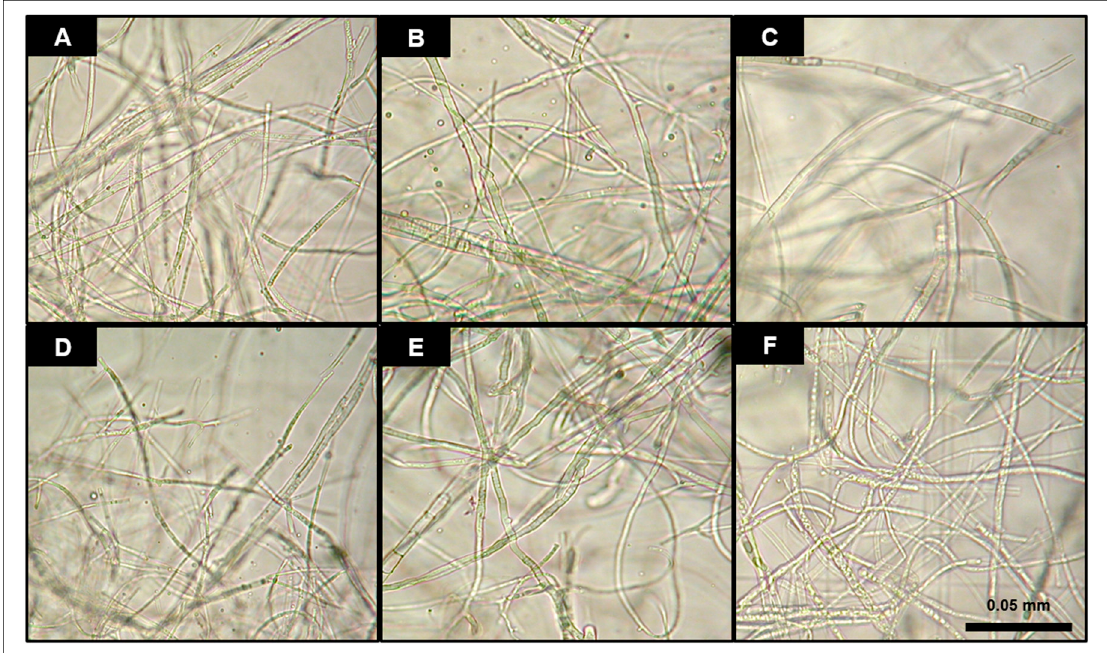
Figure 3. Microscopic morphology of hyphae in 40-days-old cultures. ( A ) 011 wildtype; ( B ) 011ect5; ( C ) Δ Fcrho1 011; ( D ) Fc072 wildtype; ( E ) Fc072ect2; ( F ) Δ Fcrho1 Fc072. Image processing: scaling to common size and +20% brightness.